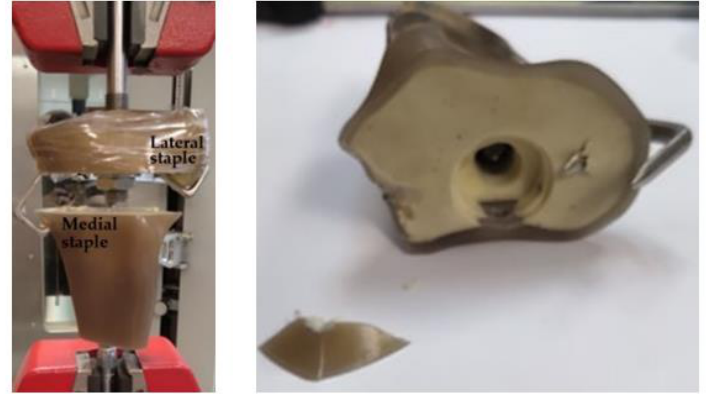
Figure 17. Experiment — Tensile force Fz (N) vs. separation of jaws (mm).